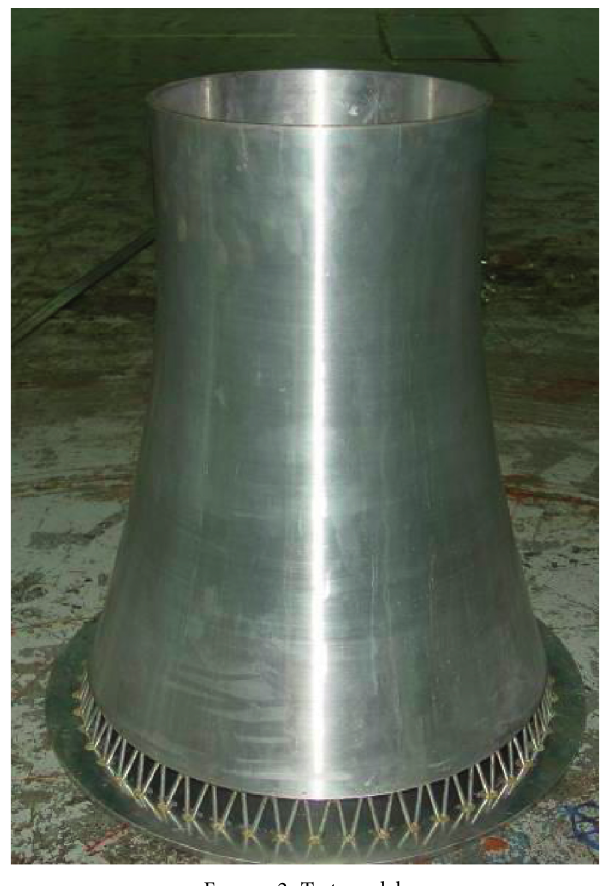
Figure 2: Test model.